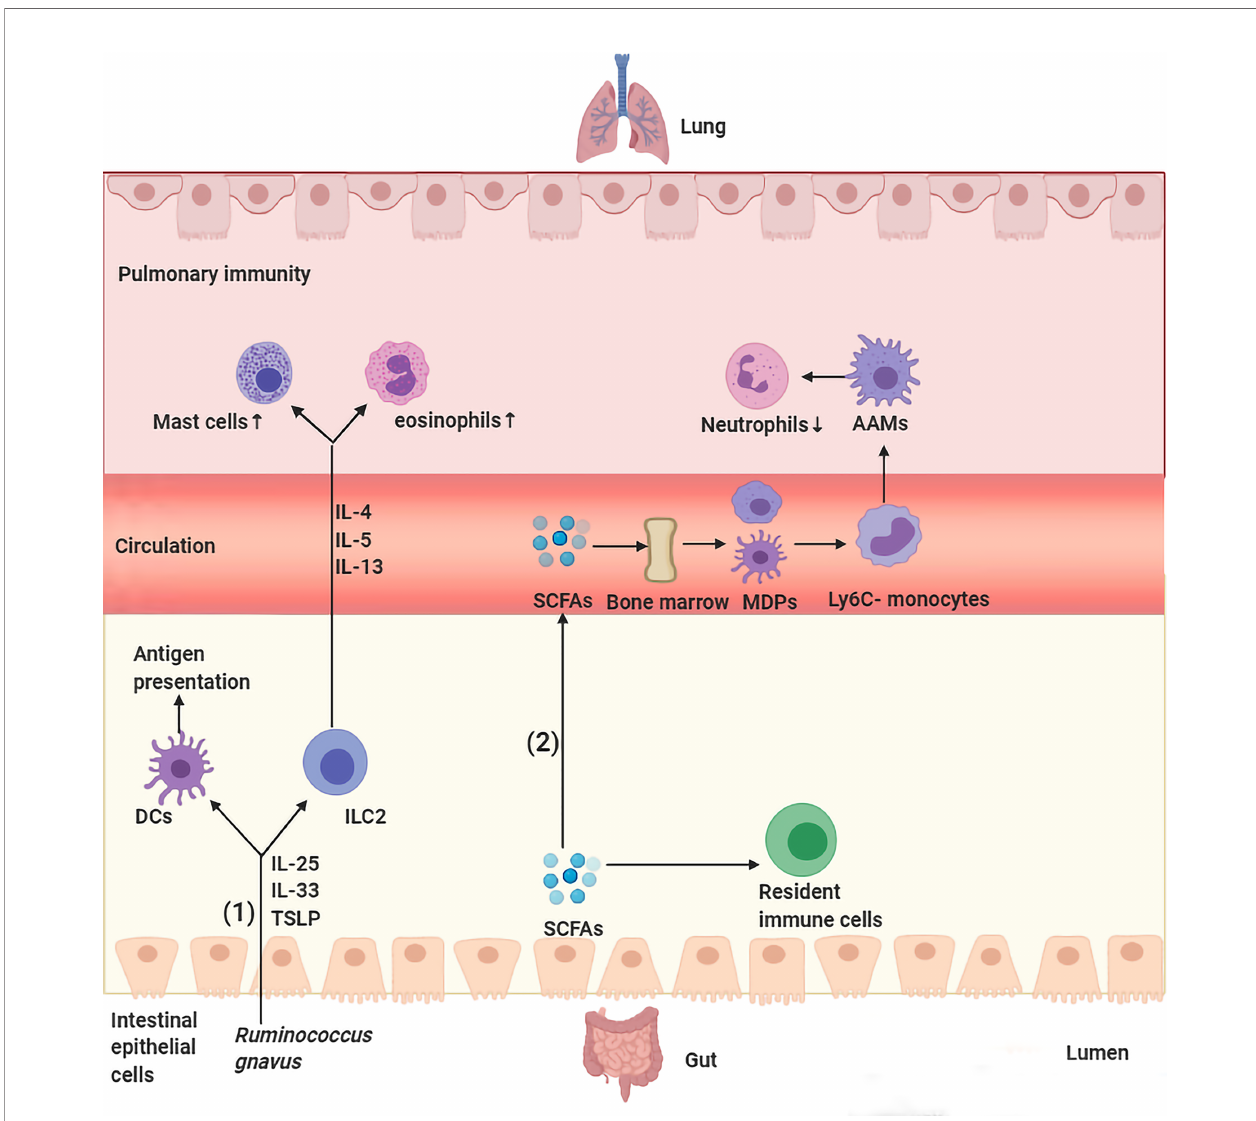
FIGURE 1 | Major routes of communications within the gut – lung axis. (1) Ruminococcus gnavus stimulates secretion of IL-25, IL-33, and thymic stromal lymphopoietin (TSLP) by colon tissues, those cytokines activate DCs and ILC2 to produce cytokines IL-4, IL-5, and IL-13 and travel through the bloodstream to the lungs and lead to in fi ltration of the lung parenchyma by eosinophils and mast cells. (2) SCFAs transform macrophage and DC progenitors (MDPs) and their commitment into Ly6C − monocytes in the bone marrow, which can differentiate into alternatively activated macrophages (AAMs) in the lungs, thus control the immunopathology caused by in fi ltrating